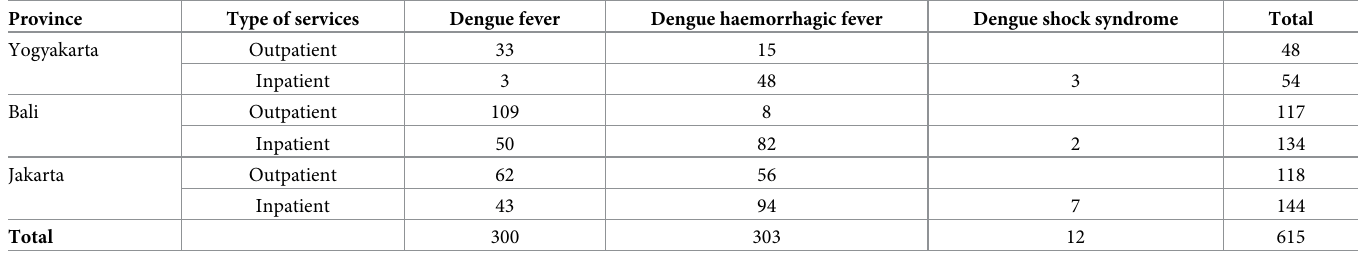
Table 1. Distribution of patient records used in the retrospective analyses, by province, type of service and severity of dengue during the period from 15 th of June to 31 st of July 2015. Province Type of